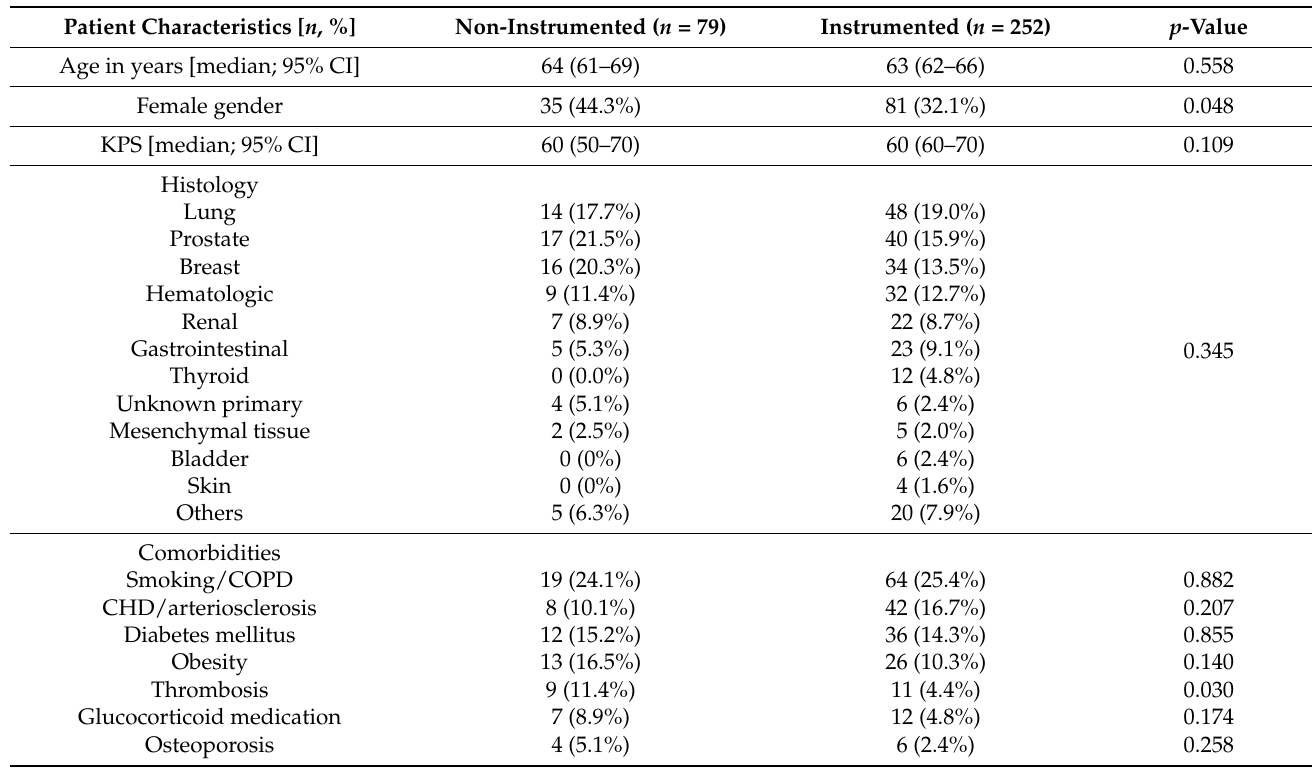
Table 1. Patient Table 1. Patient characteristics.